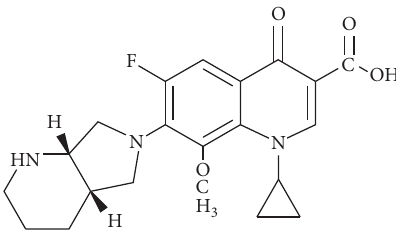
Figure 1: Structure of